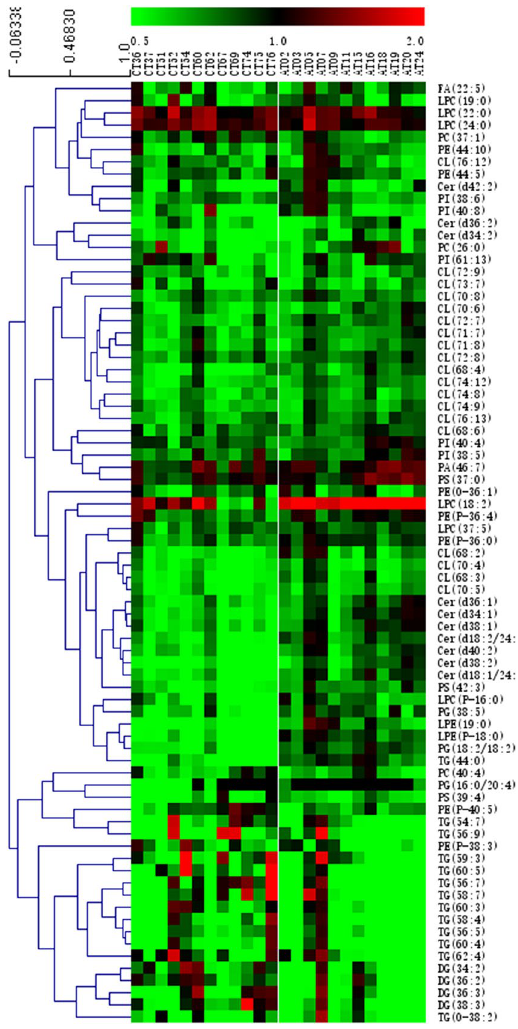
each myocardial sample over the average abundances of the corresponding lipids in respective controls. Green represents downregulation in abundance while red represents